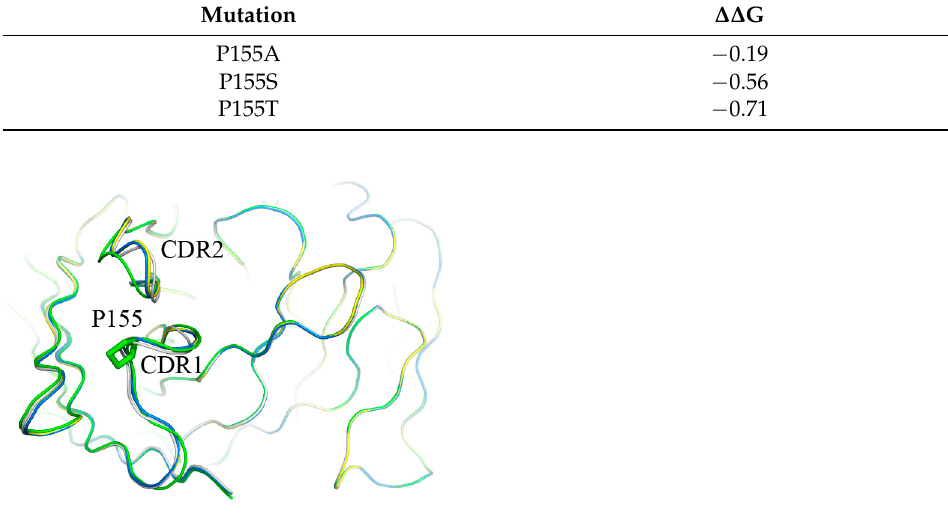
Figure 12. The modelling 3D structures of the antibodies. Green: wild-type antibody. Blue: P155A. Yellow: P155S. Gray: P155T. Pro at position 30 of heavy chain are highlighted by stick model. The nearby loops including CDR2 showed conformation changes induced by the residue substitutions at position 30.